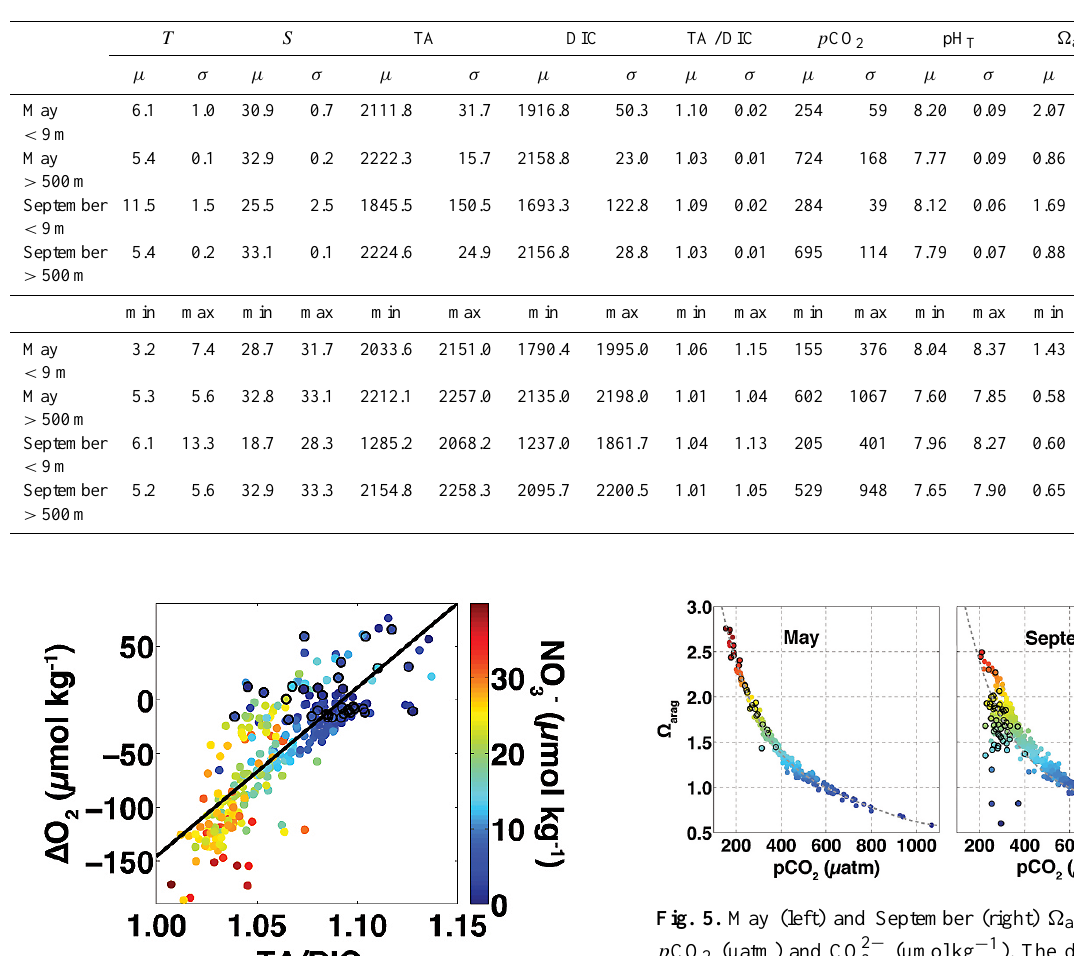
Table 1. Mean ( µ ), standard deviation ( σ ), minimum and maximum values of T , S , TA (µmolkg − 1 ), DIC (µmolkg − 1 ), TA/DIC, p CO 2 (µatm), pH T , (cid:127) arag and (cid:127) calc for surface ( < 9m) and deep ( > 500m) samples collected in PWS in May and September. The total number of measurements for each parameter was 744; the number of May surface and deep data was 25 and 7, respectively; the number of September surface and deep data was 54 and 20, respectively.